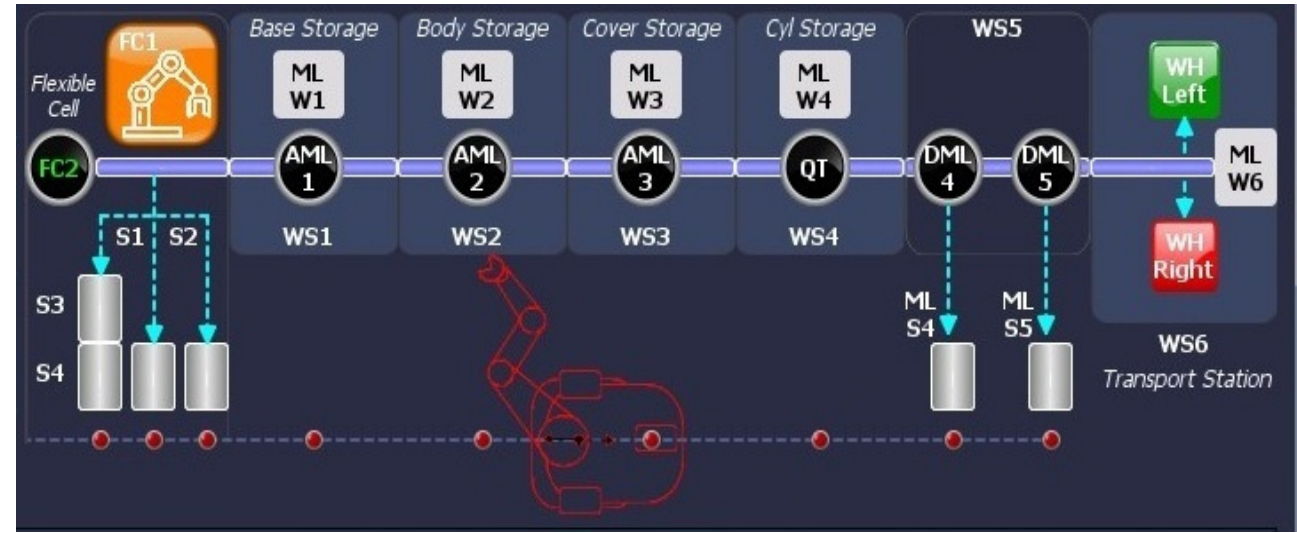
Figure 5. Hera&Horstman assembly/disassembly mechatronics line.